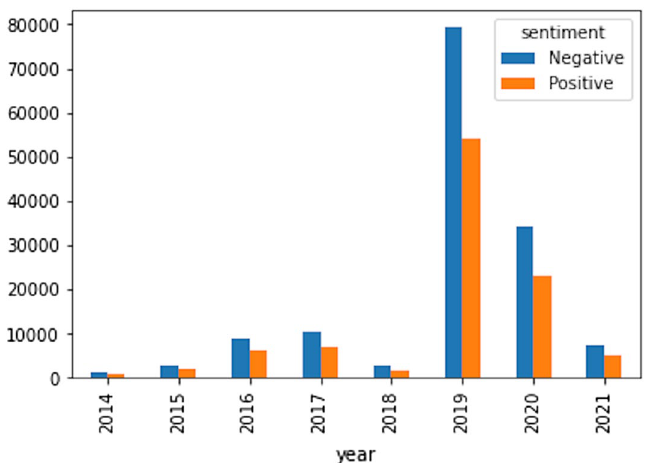
Fig. 9 Distribution of positive and negative tweets (annual)